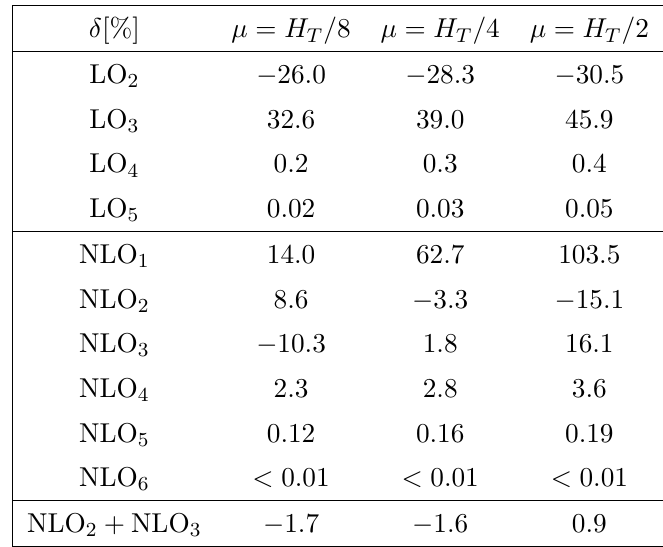
Table 7 . t (cid:22) tt (cid:22) t : (cid:27) =(cid:27) LO ratios at 13 TeV, for di(cid:11)erent values of (cid:22) = (cid:22) r = (cid:22) f . (N)LO i QCD